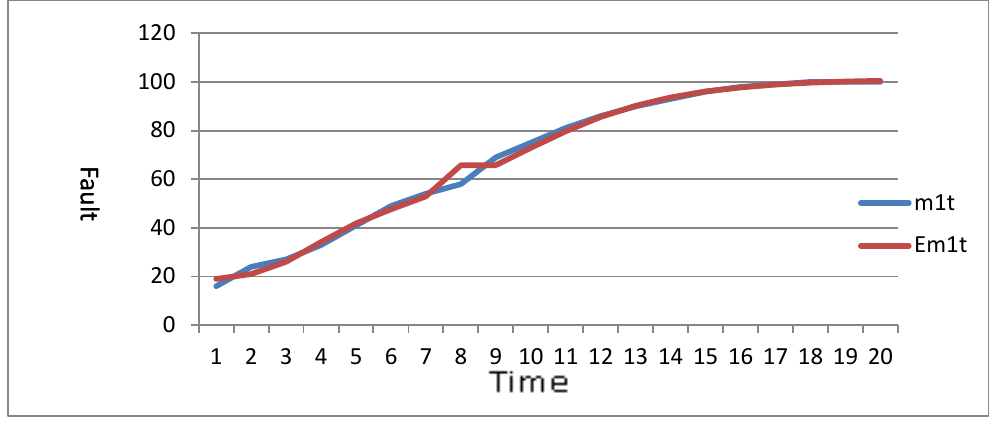
Fig. 2. Goodness of fit curve for release-1